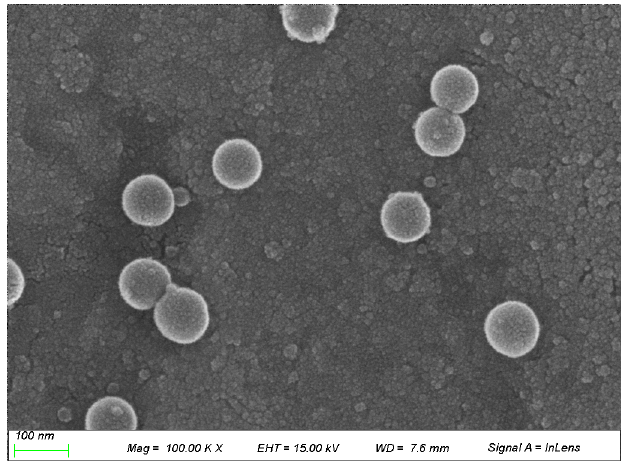
Figure 5. Scanning electron microscope (SEM) image of MTX-loaded PLGA NPs.